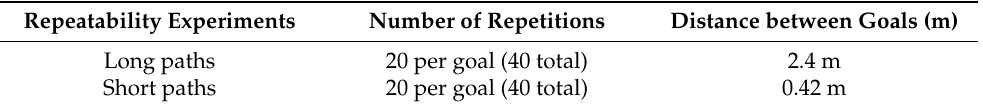
Table 2. Summary of repeatability